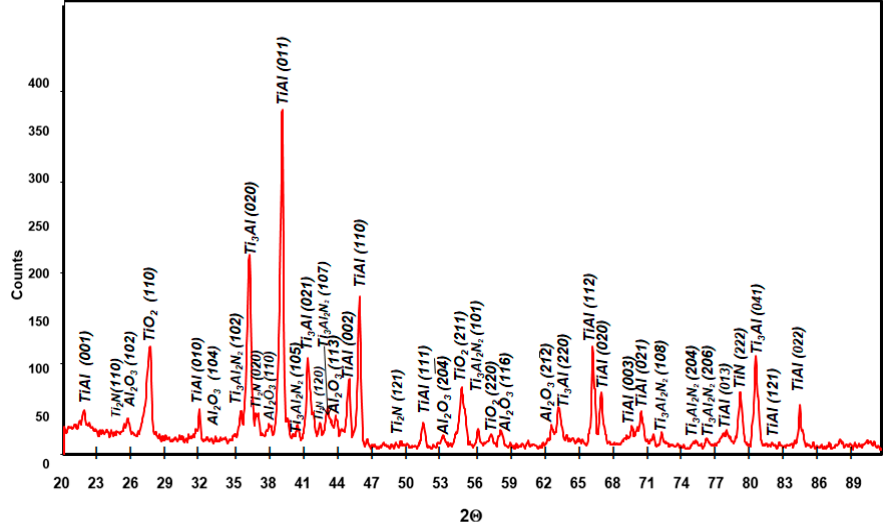
Figure 21. XRD pattern showing the predominant phases formed during oxidation of Ti–46Al–7Nb– 0.7Cr–0.1Si–0.2Ni alloy at 875 °C (scale was removed from the samples).